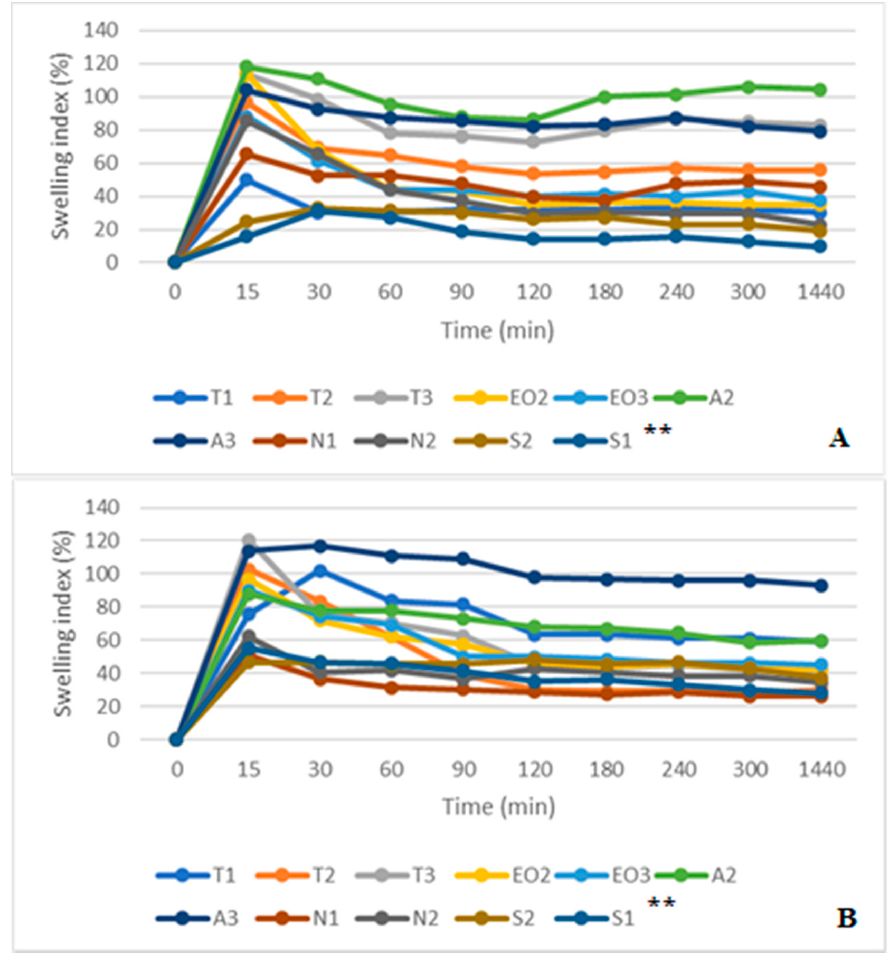
Figure 11. ( A ) NEO-loaded calcium alginate microcapsules swelling in simulated gastric juice (SGF) medium. ( B ) NEO-loaded calcium alginate microcapsules swelling in SGF + pepsin medium. ** The